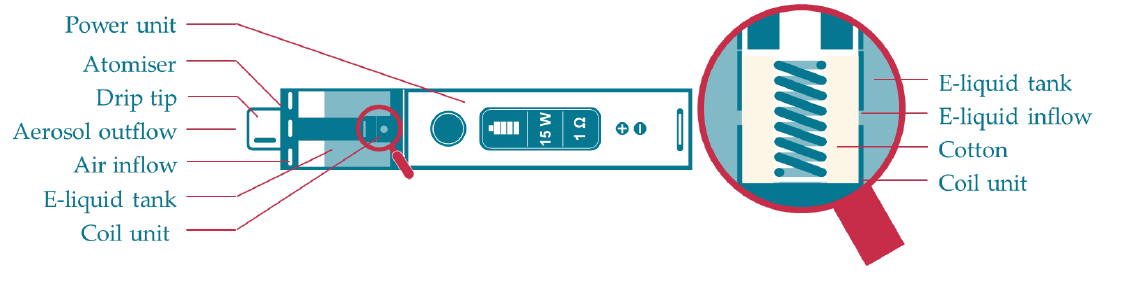
Figure 1. Scheme of an e-cig.